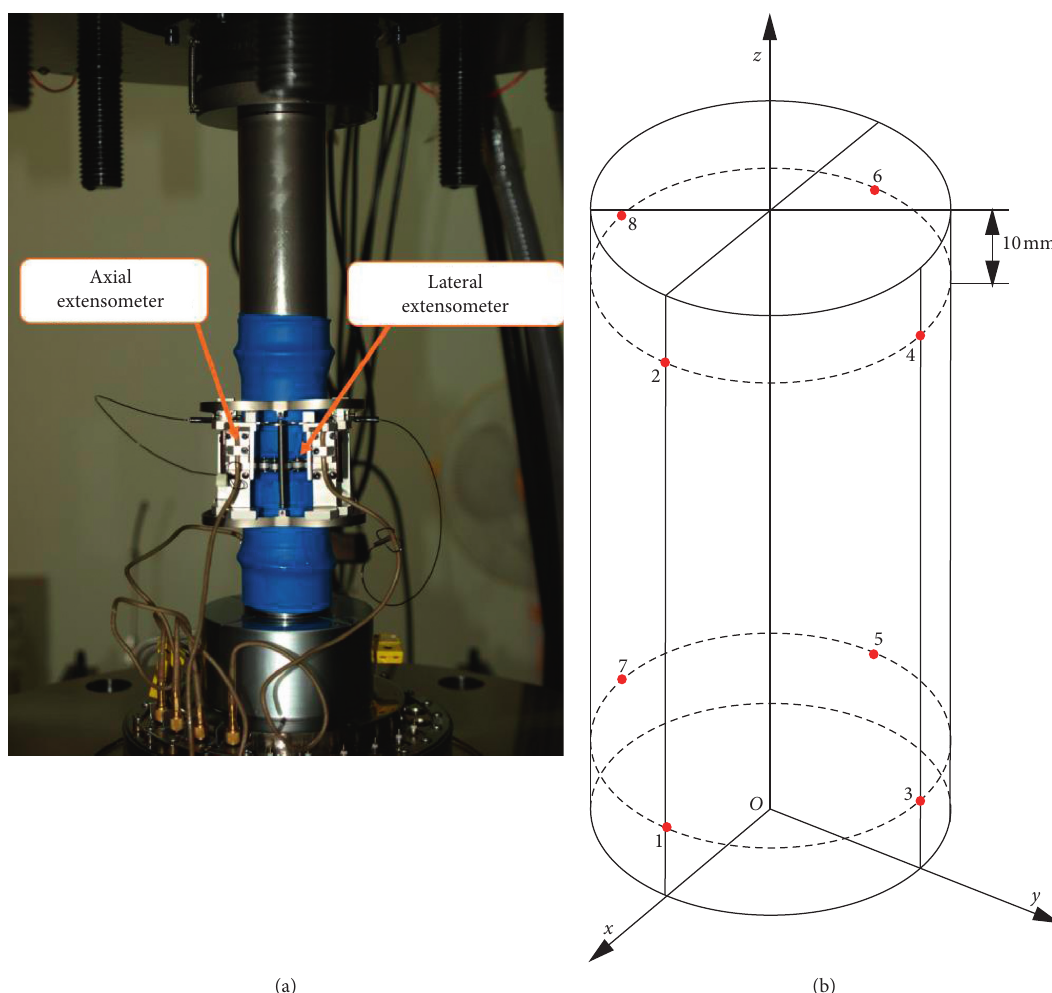
Figure 2: Coal rock triaxial compression test system. (a) Triaxial compression test system. (b) Acoustic emission monitoring pressure is set to 25 MPa and the loading strain rate is set (Figure 2(a)). Different strain rates are achieved by setting to10 − 5 s − 1 , 10 − 4 s − 1 , and 10 − 3 s − 1 . different loading speeds, which are controlled by the linear variable differential transformer (LVDT). To simulate the The AE test was performed by the PCI-2 AE test system dynamic disturbance of deep buried coal rock during the of the United States. It synchronizes AE feature parameters, normal excavation process, the test loading confining waveform acquisition, and analysis. Considering the specific